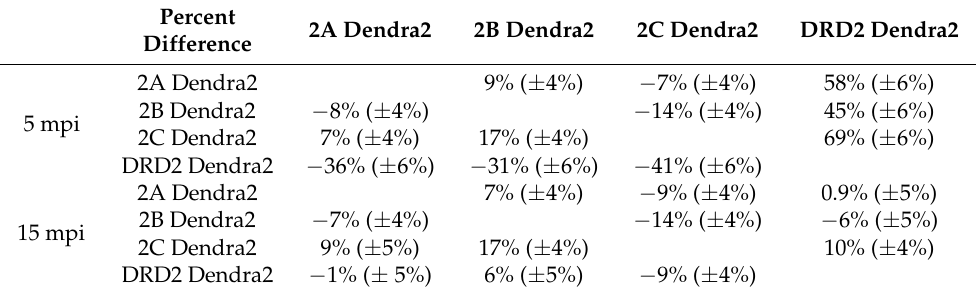
Table 2. Summary of percent difference of JCPyV-647 Manders’ colocalization coefficient with all 5- HT 2 R subtypes and DRD2 at 5 mpi and 15 mpi. Each row shows the comparison of the sample at the start of row (left) with samples in individual columns and expresses the percent increase/decrease in the sample on the left to that of the one in the